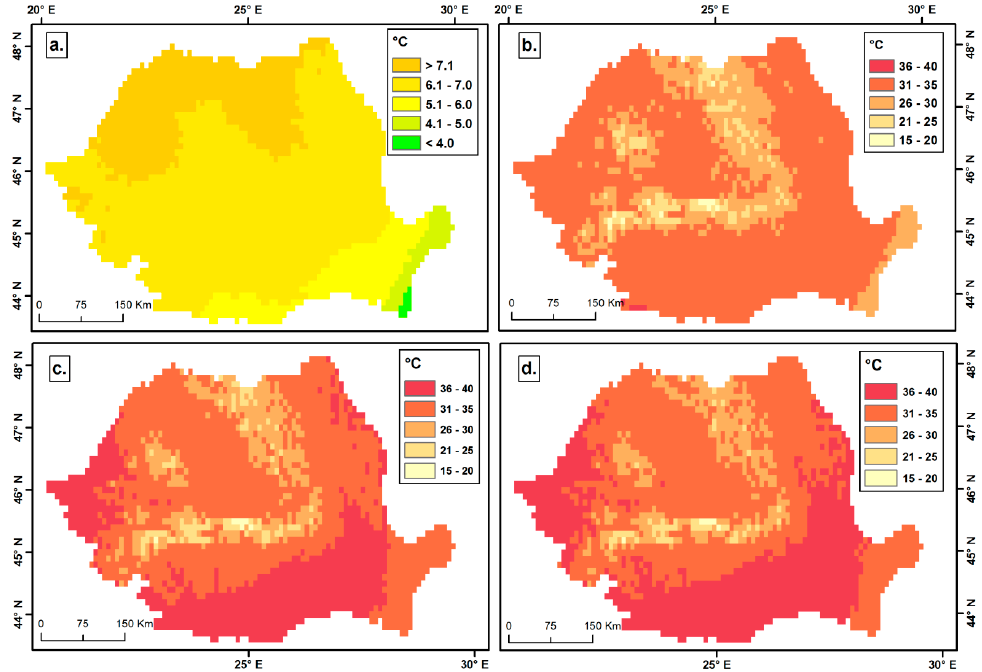
Figure 9. Mean maximum temperature anomaly in Romania in summer ( a ); and mean maximum temperature in: June ( b ); July ( c ); and August ( d ) for A1 HW type based on RO manian C lim A tic DA taset (ROCADA) gridded database.